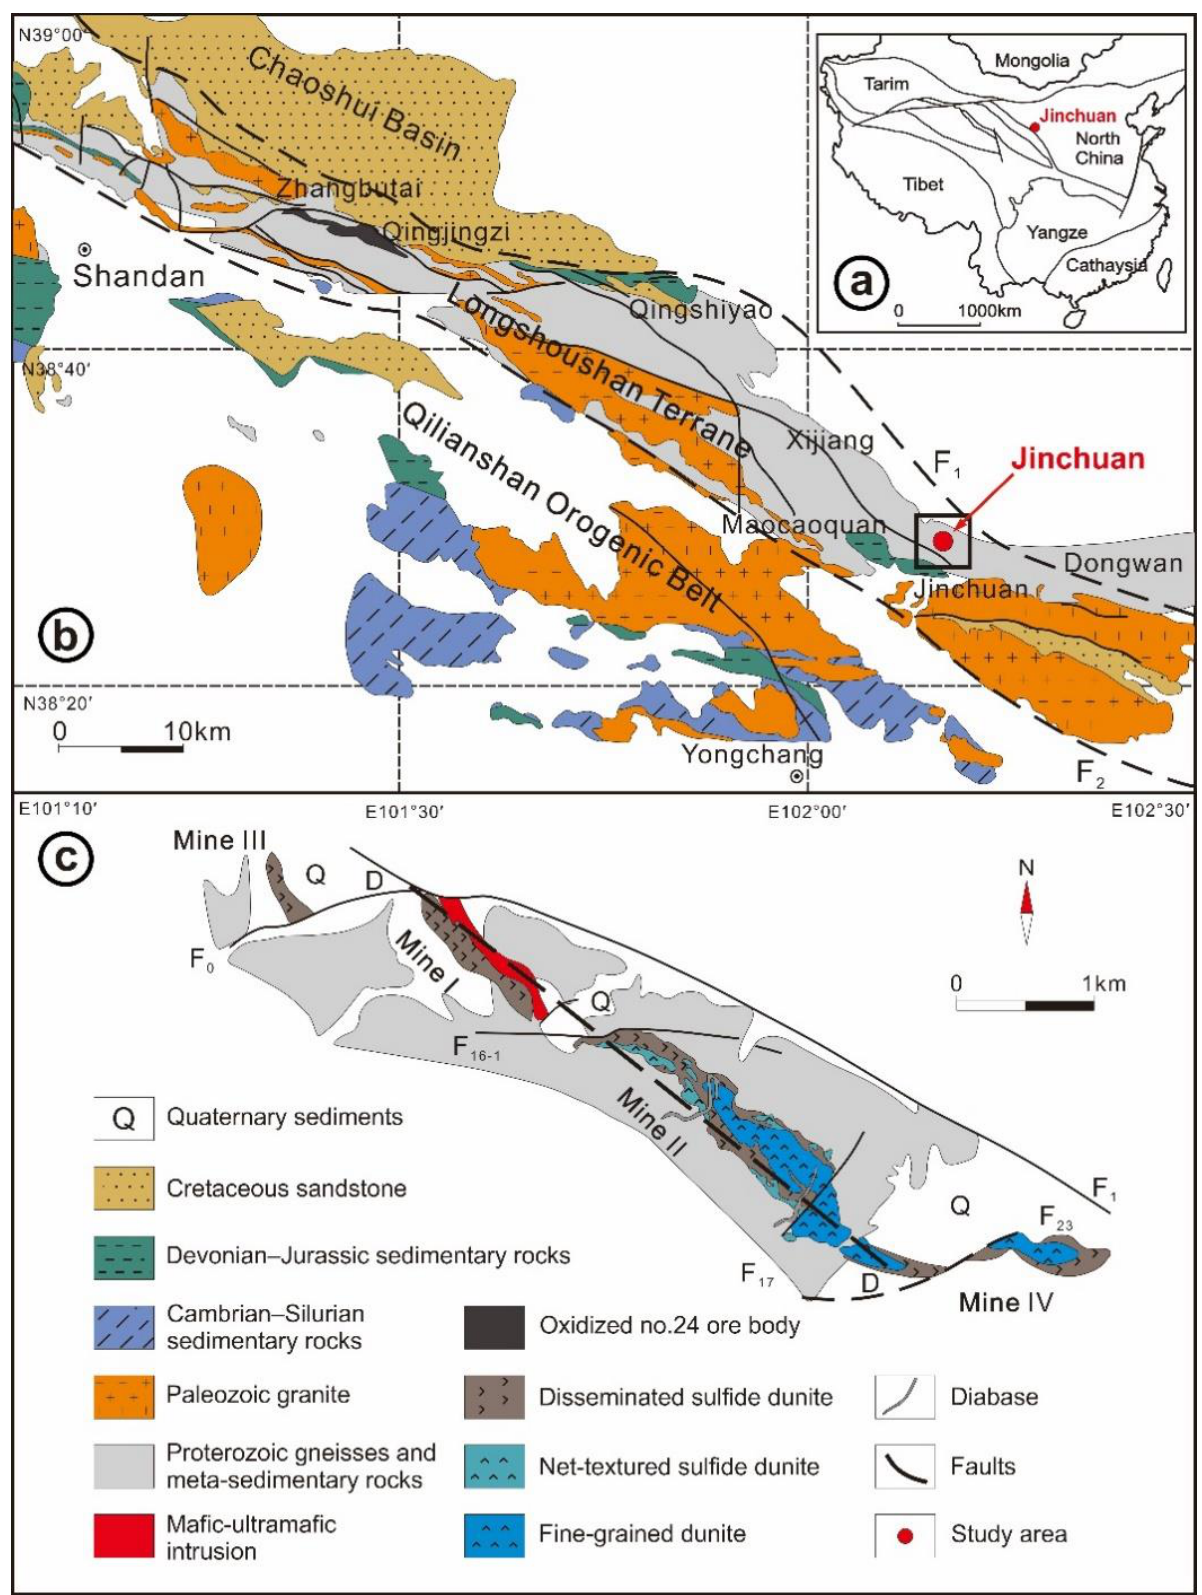
Figure 2. Simplified geological maps showing major tectonic units of China ( a ) (modified from [25]), location of the Jinchuan magmatic Ni-Cu ore deposit in the Longshoushan terrane in the context of regional geology ( b ) and distribution of ore bodies in the Jinchuan deposit ( c ) (modified from [26,27]).